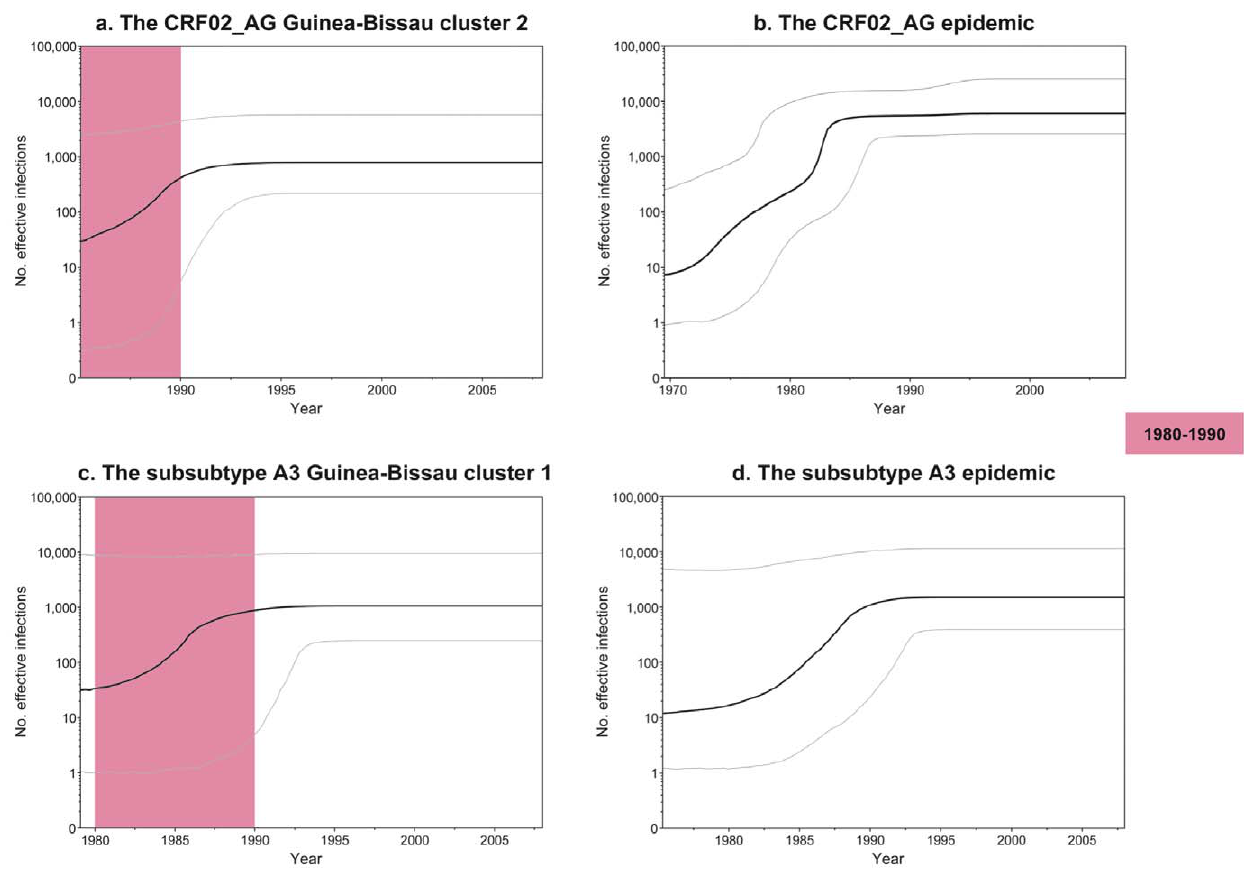
Figure 2. a–d. Bayesian skyline plots for the CRF02_AG and subsubtype A3 epidemics. Non-parametric median estimates of the number of effective infections over time for a. the CRF02_AG Guinea-Bissau cluster 2, b. the CRF02_AG epidemic in West Africa, c. the subsubtype A3 Guinea- Bissau cluster 1, and d. the subsubtype A3 epidemic in West Africa. All plots were based on the relaxed clock assumption. The grey lines represent the upper and lower 95% highest posterior density estimates. The pink area highlights the decade following the time period (1976–1981) of the estimated HIV-1 introductions into Guinea-Bissau. (Figure 1a). The introduction of the major CRF02_AG cluster dated back to 1976, and was then followed by several introductions during the late 1970’s and early 1980’s. The timing of these introductions fits well with the results from early studies of HIV-1 seroprevalence in West Africa [22,29]. In a study by Fultz et al. , one out of 440 analyzed serum samples collected in 1980 reacted in an HIV-1 radio-immunoprecipitation assay, and were considered to be potentially HIV-1 positive by the authors [22]. Kanki et al. analyzed 2131 serum samples, collected 1985–1987, from Guinea-Bissau and the neighbouring countries Senegal, Guinea and Mauritania and found an HIV-1 seroprevalence of 0–0.7% in the analyzed samples [29]. The results of these studies indicate an arising HIV-1 epidemic in West Africa during the early 1980’s. The estimated dates of the HIV-1 CRF02_AG introductions into Guinea-Bissau are also in line with the scenario seen in the demographic analyses. The Bayesian skyline plot (BSP) analysis suggested an initial and almost asymptotic growth period of effective infections followed by a rapid exponential growth phase, starting around 1985 with a median of 30 effective infections and ending in 1990 with an almost 20-fold increase in median effective infections to 562 in Guinea-Bissau (Figure 2a). A similar pattern was seen in the analysis of the prevalence of current lineages over time. Only 23% of the current Guinea-Bissau lineages existed in the country in 1980. In 1985 the number had increased exponentially to 79%, and in 1990 almost all